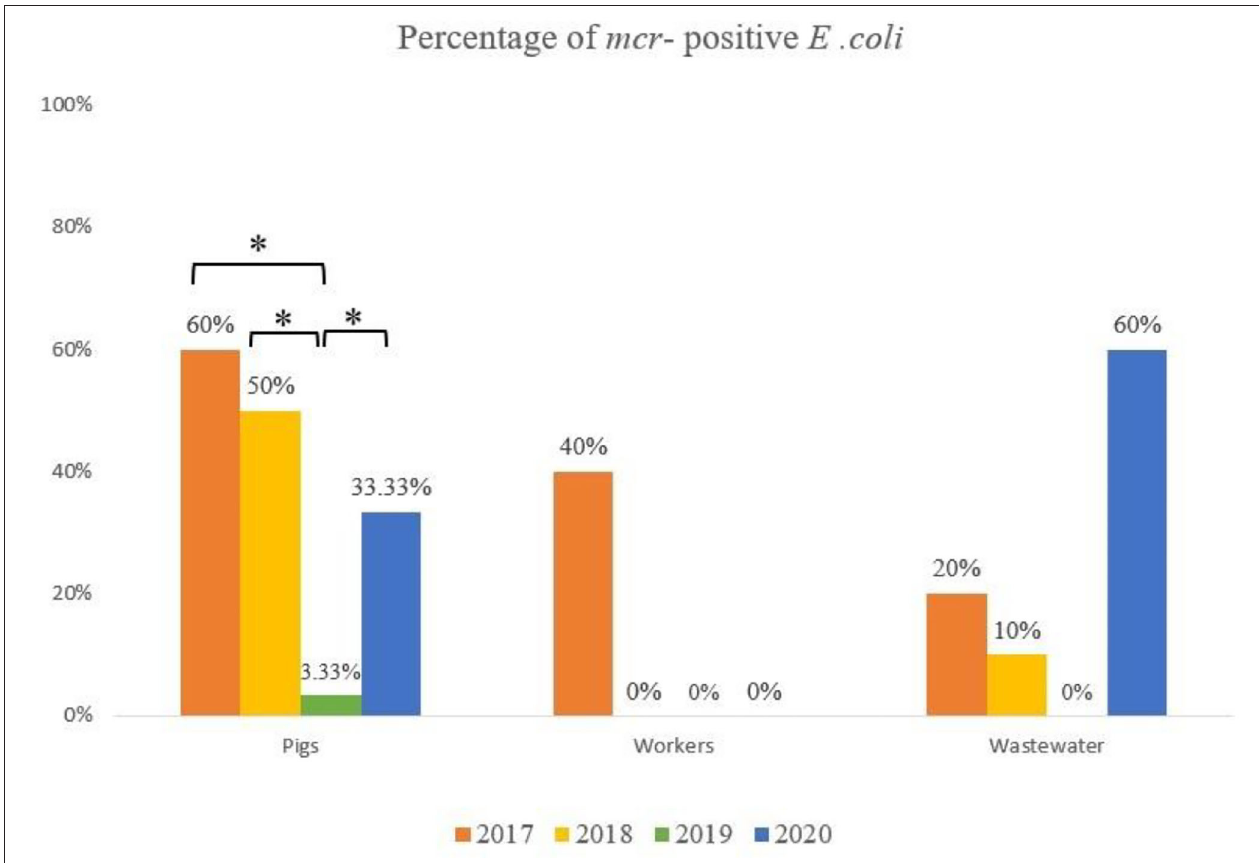
FIGURE 1 | Comparison of the rate of mcr positive E. coli isolated from pigs, workers and the environment in four sample collection years (*significant difference; p ≤ 0.05).